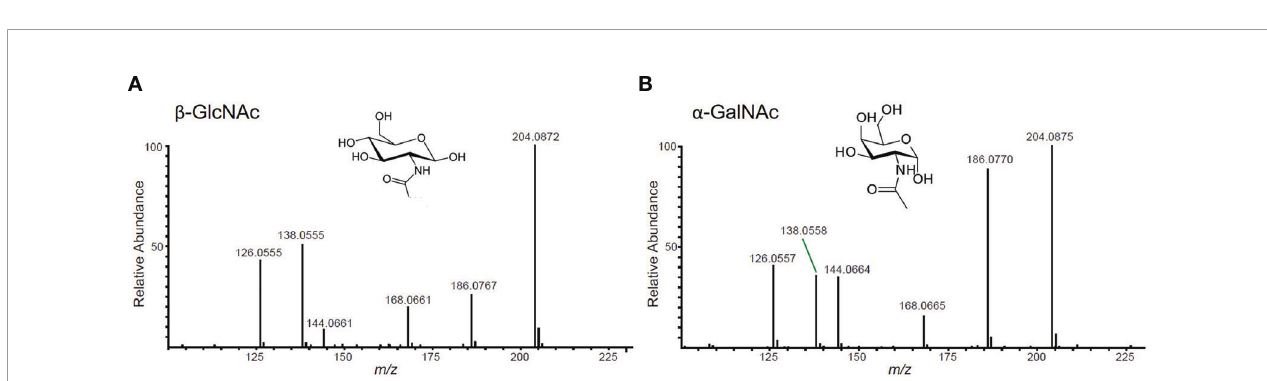
FIGURE 3 | Representative HexNAc fi ngerprints. (A) GlcNAc-containing glycopeptides will have a higher abundance of the ion at 138 m/z than the ion at 144 m/z . This fi ngerprint will be present in peptides with N-glycans, O-GlcNAc, and/or GlcNAc-containing core 2 O-glycans. (B) GalNAc-containing glycopeptides will have nearly equal abundance of 138 m/z and 144 m/z ions. This fi ngerprint will be present in mucin-type glycopeptides that do not contain GlcNAc.